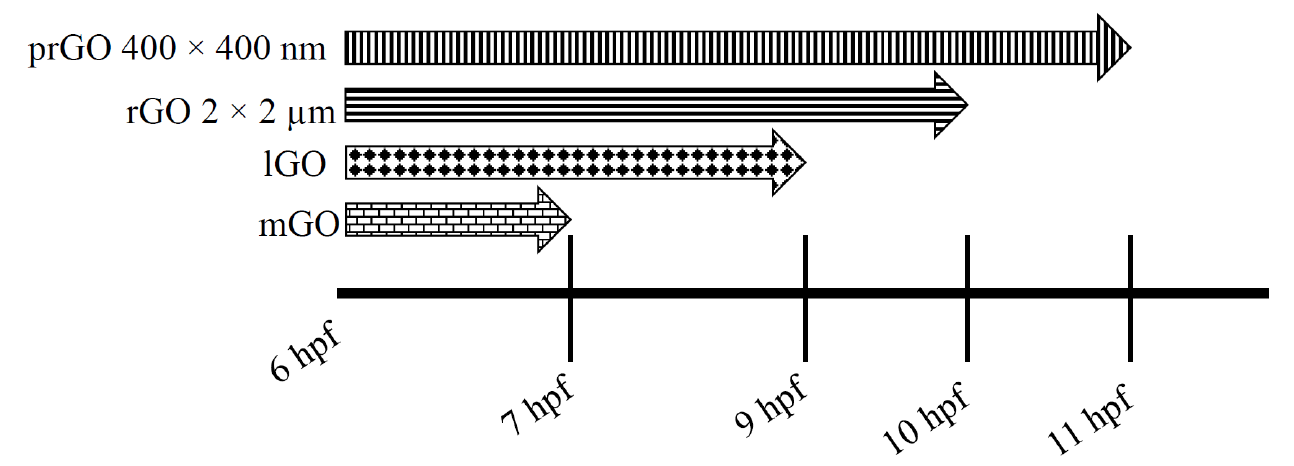
Figure 5. Window of susceptibility starting at 6 hpf. All GOs were tested at 50 µ g/mL. mGO (brick pattern) caused the most rapid mortality with significant mortality observed at 7 hpf ( p = 0.037). lGO (diamond pattern), rGO 2 μm × 2 μm (horizontal stripes), and prGO 400 nm × 400 nm (vertical stripes) caused significant mortality 9 hpf ( p = 0.027), 10 hpf ( p = 0.012), and 11 hpf ( p = 0.012) (respectively). Significant mortality at specified timepoints was determined by Welch’s t -tests ( α = 0.05).